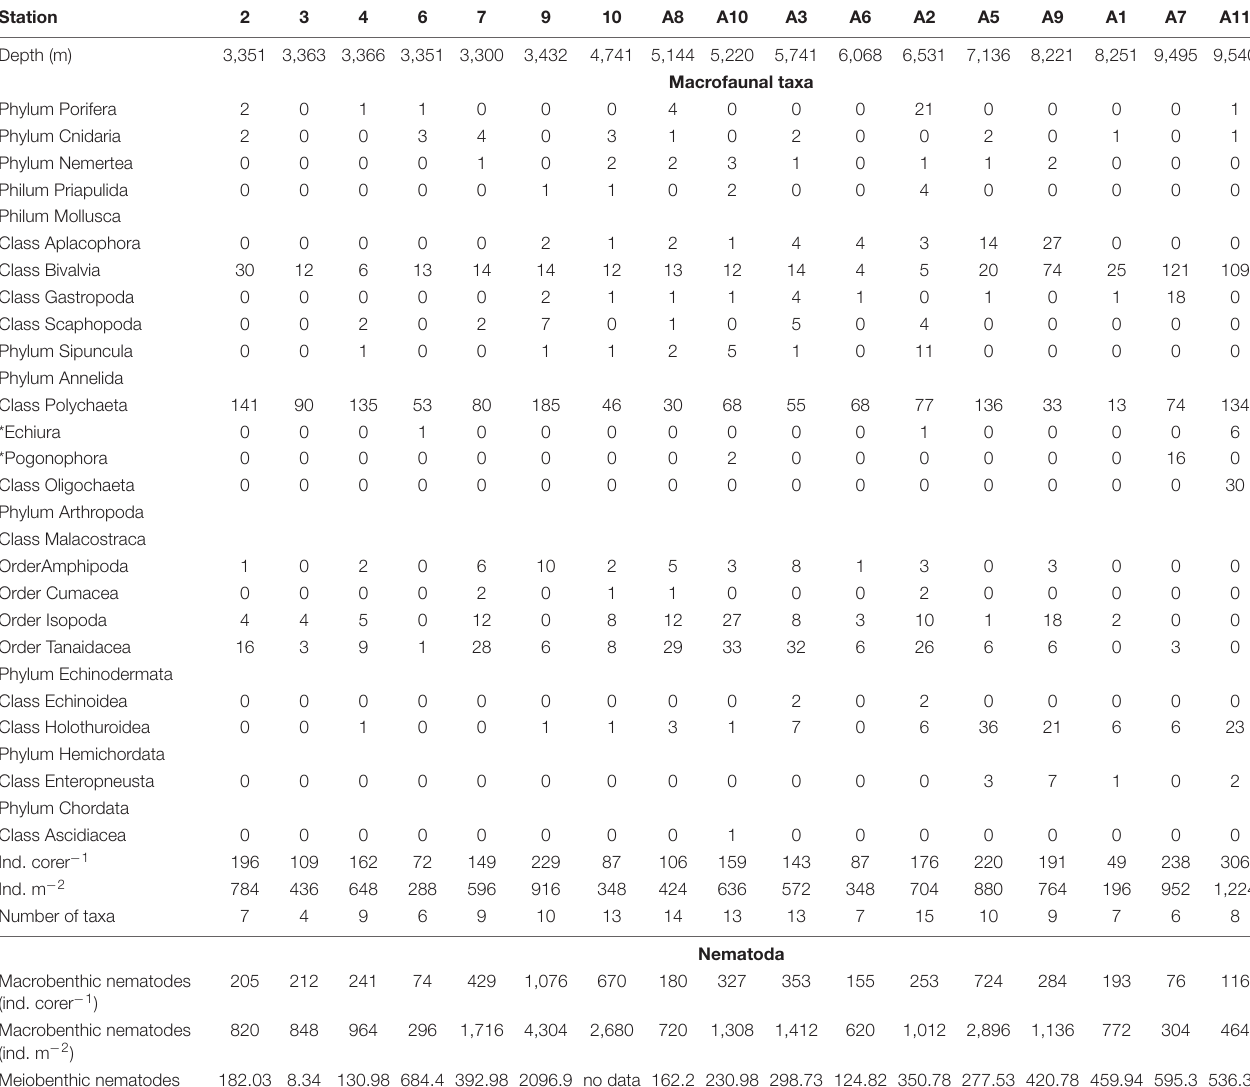
TABLE 2 | Abundance of macrofaunal taxa, macro- and meiobenthic nematodes at the SokhoBio and KuramBio II stations in the Kuril Basin (Sea of Okhotsk) and the Kuril-Kamchatka Trench area (Pacific Ocean).